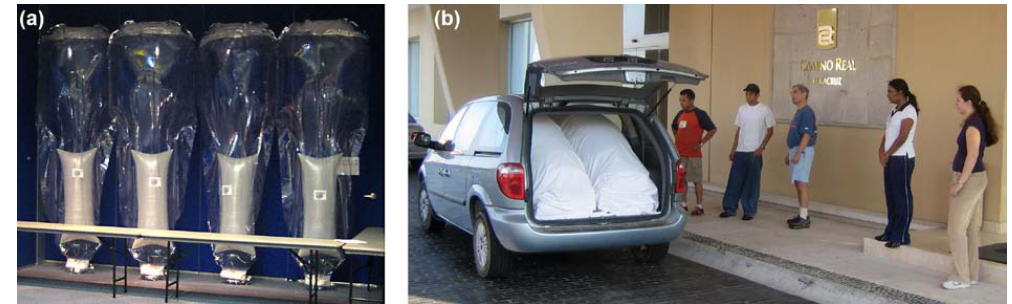
Fig. 2. (a) Four CMET balloons being ballasted at the MILAGRO Aircraft Operations Center in Veracruz. (b) Two of the balloons packed into a minivan for transport to Mexico City. The balloons were launched into the areas of highest pollution as determined by models and by observations from aircraft, satellites, ground stations, and the launch team. Four undergraduate science and engineering students from Mexico and the United States and a k-12 teacher, in the photo at right, contributed to the CMET balloon study.